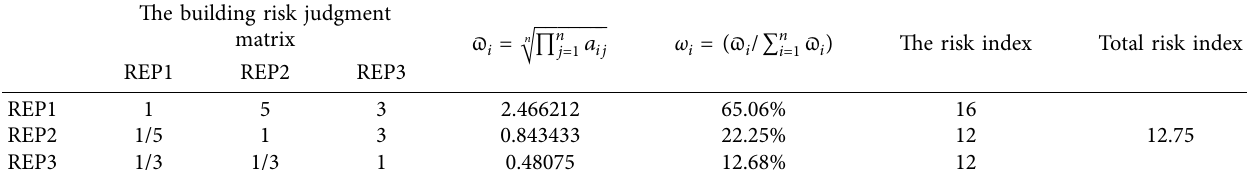
Table 38: The building risk judgment matrix.